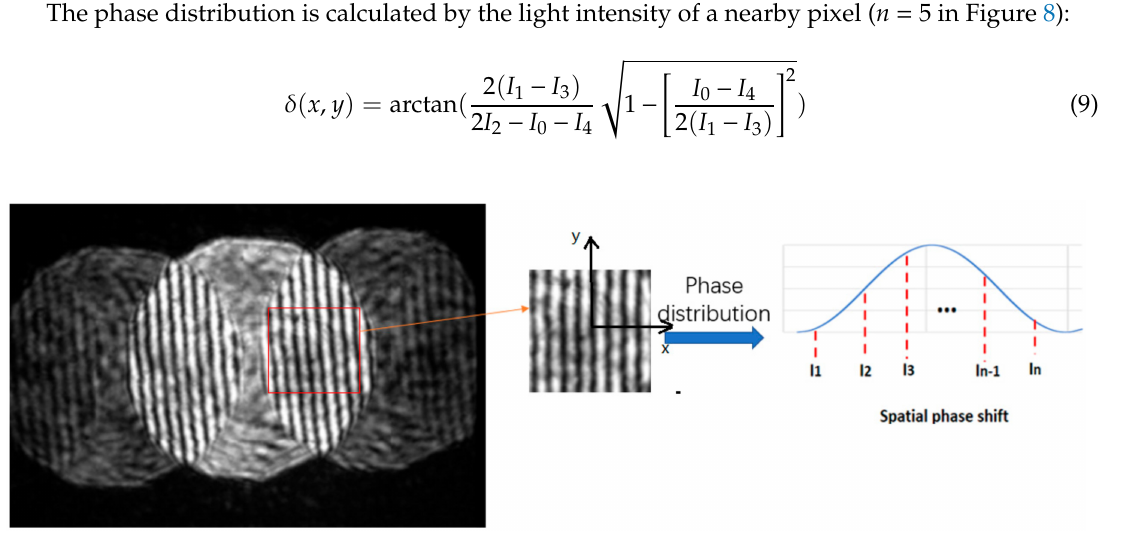
Figure 8. Phase parsing by spatial domain phase shift technique.